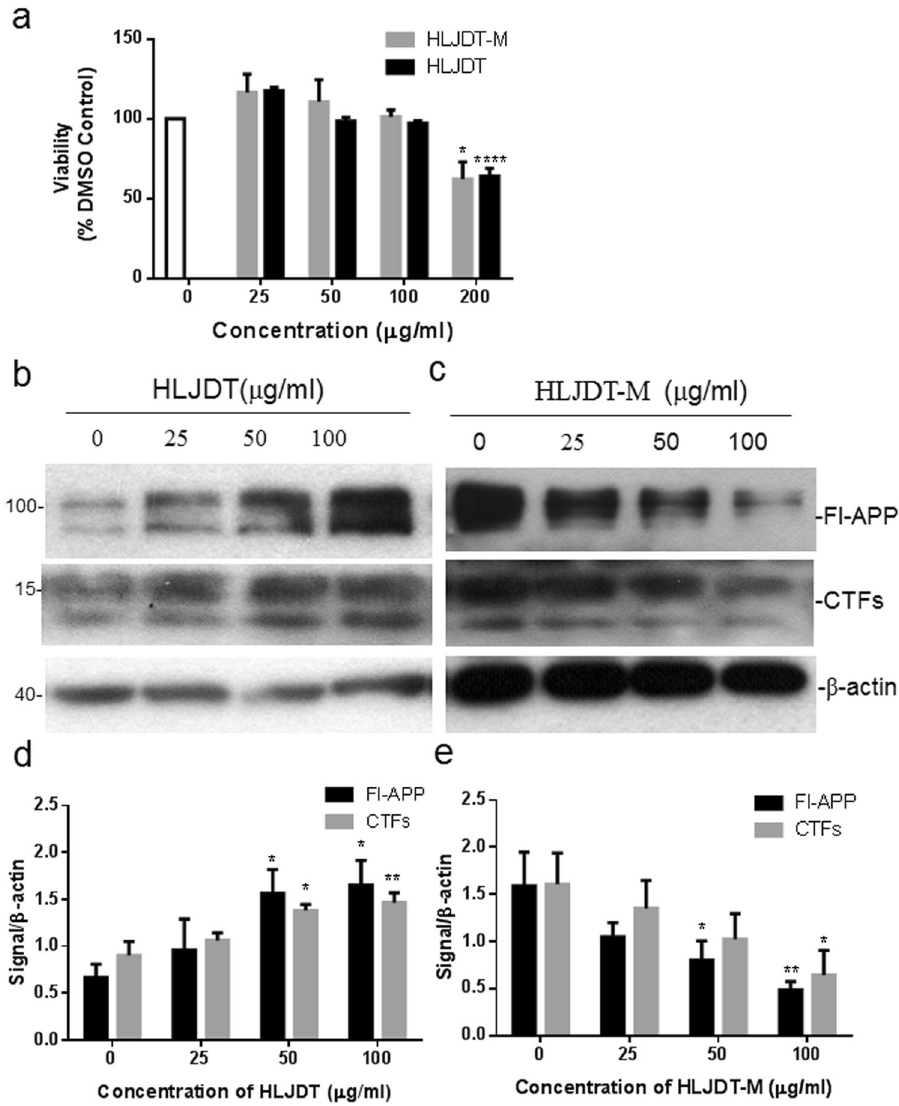
Figure 6. Treatment of N2a-SwedAPP cells with HLJDT-M and HLJDT differentially modulated the processing of APP. Cells incubated with aqueous extract of HLJDT or HLJDT-M at three different concentrations (25, 50 or 100 μ g/ml) or with vehicle for 48 hours. After incubation, cell lysates were probed for APP and CTFs by Western blot. The statistical significance among different groups are represented as * p < 0.05, ** p < 0.01, ** p <